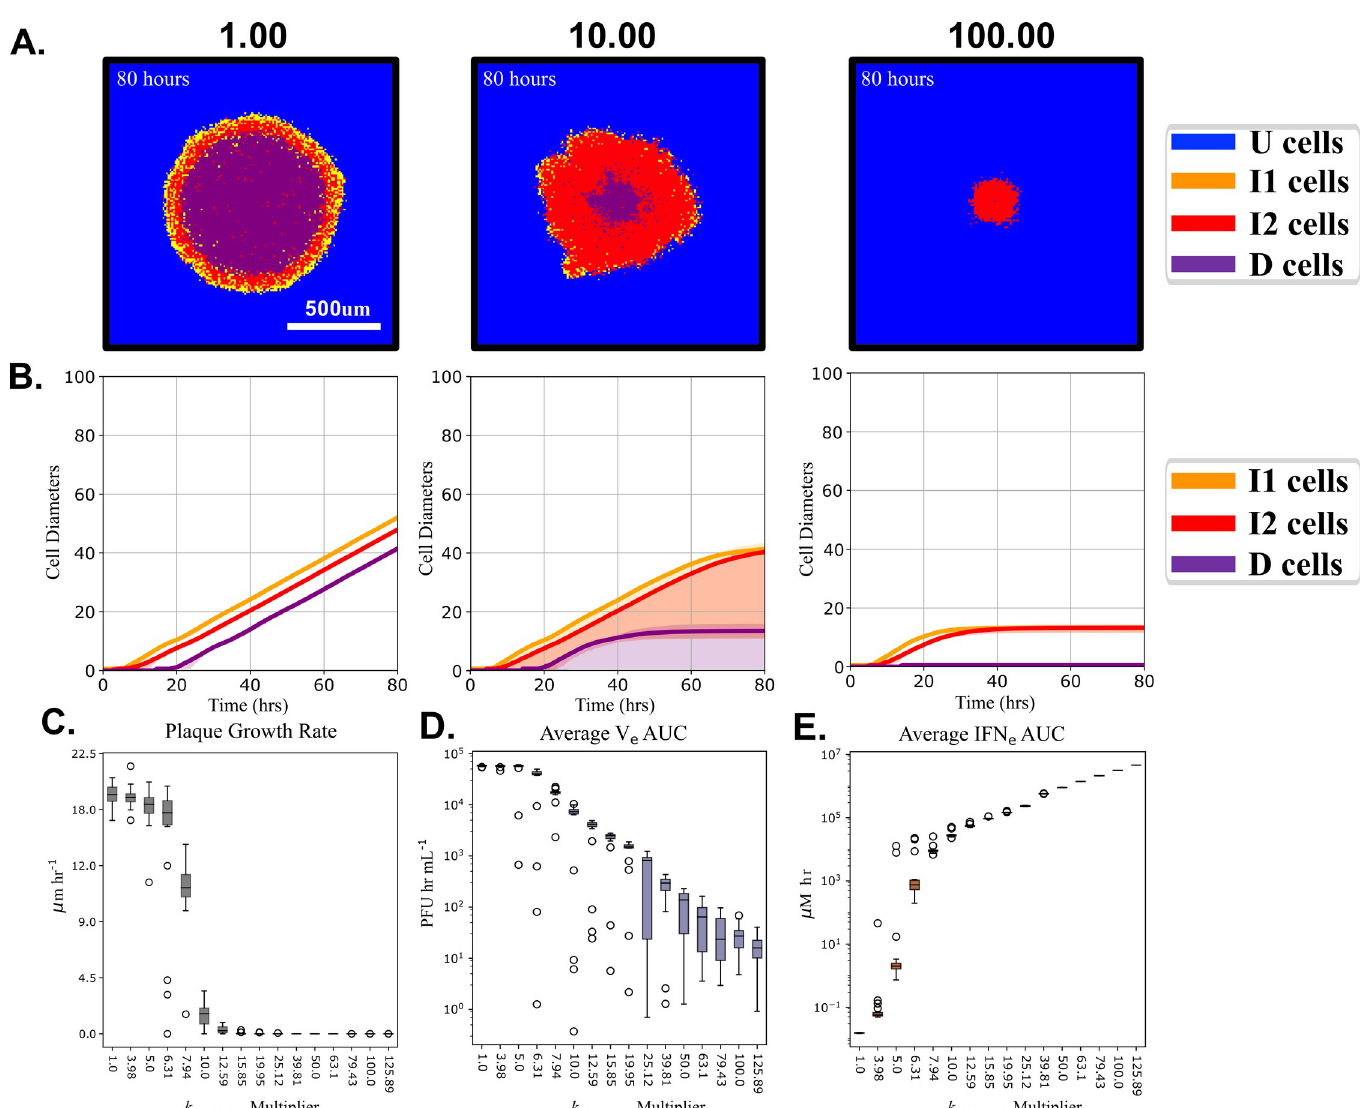
Fig 5. Elevated STATP activity (larger k STATP , IFNe ) leads to arrested plaque growth. (A) Images of the simulated plaques at 80 hours post-infection for a single simulation replica when k was 1x, 10x, or 100x larger than its baseline value. Arrested plaque growth occurs when k STATP , IFNe (B) The median (solid line) and 5 th and 95 th percentiles (shaded regions) for 20 simulation replicas of the cell types over time for k STATP , IFNe at 1x, 10x, or 100x larger than its baseline value of 45.9 μ M hr -1 . (C) The plaque radius’ linear growth rate at 80 hours, (D) the area under the curve (AUC) of the average V e , and (C) the AUC of the average IFN e when k is changed between its nominal value to 125.98x nominal, over 20 simulation STATP , IFNe